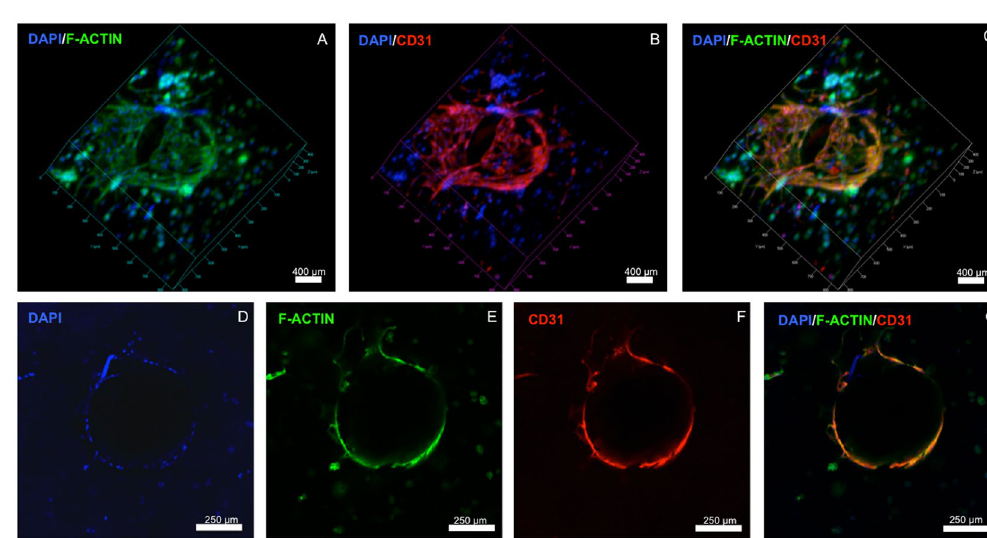
Figure 8. Confocal images of endothelialized microchannels in an OD21-laden GelMA hydrogel cultured in a full-length dental pulp-like tissue constructs. ( A – C ) 3D rendering and ( D – G ) cross-sectional slices of confocal images showing ECFC monolayer formation and angiogenic sprouts in the engineered microchannel in the dental pulp-like tissue constructs on day 7. Cells were stained for actin (green), DAPI (blue) and CD31 (red). Z-stack movie for 3D rendering of this image is available as Supplementary Video